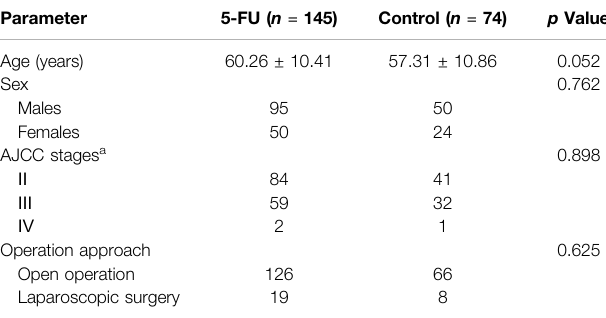
TABLE 1 | Baseline clinical characteristics of the patients. Parameter